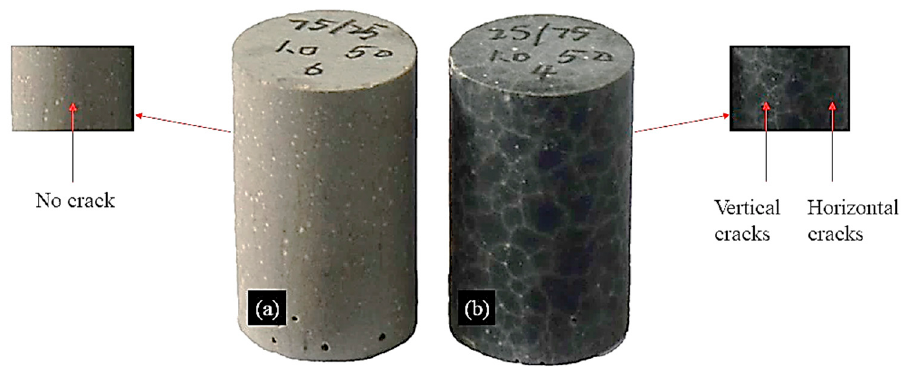
Figure 16. Comparison of cracks between B1 ( a ) and B3 ( b ) of AA-FASM.